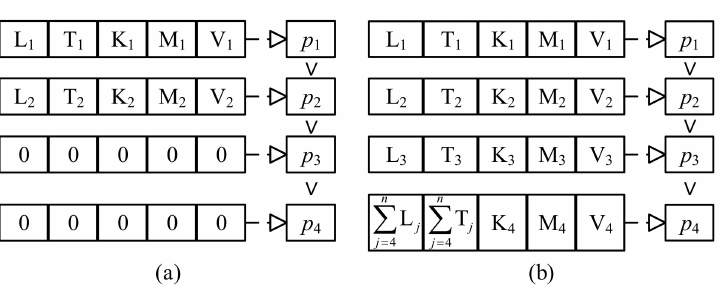
Figure 5. ( a ) Code of the physical parameter set when n = 2; ( b ) code of the physical parameter set when n ≥